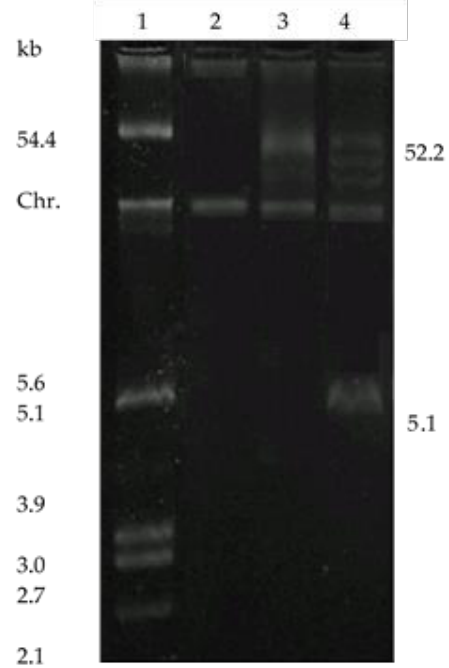
Figure 4. Plasmid profiles of E. faecium E23, E. faecalis JH2-2 and their transconjugants. Lane 1: molecular size markers prepared from E. coli V517 (54.4, 5.6, 5.1, 3.9, 3.0, 2.7 and 2.1 kb); lane 2: E. faecalis JH2-2 recipient strain; lanes 3: E. faecalis JH2-E23 transconjugant strain: lane 4: E. faecium E23 parental strain (52.2 kb). Chr. denotes the position of chromosomal